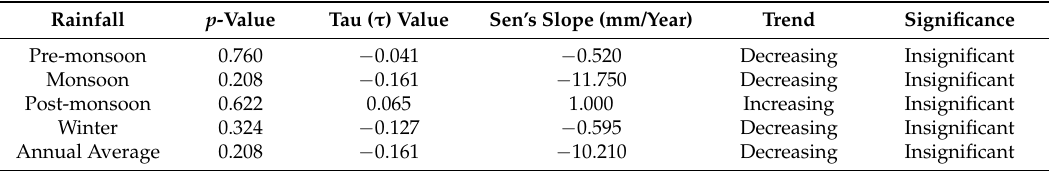
Table 4. Mann–Kendall test and Sen’s slope results for variation in rainfall between 1984 and 2014. Rainfall p -Value Tau ( τ ) Value Sen’s Slope (mm/Year) Trend